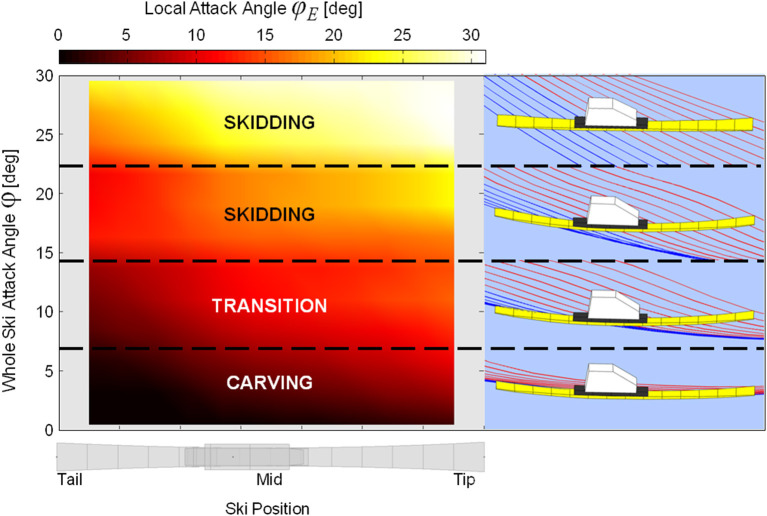
Mean local ski attack angle averaged across whole ski attack angle (left panel). An example ski making the transition from skidding to carving through a turn is shown in the right panels.